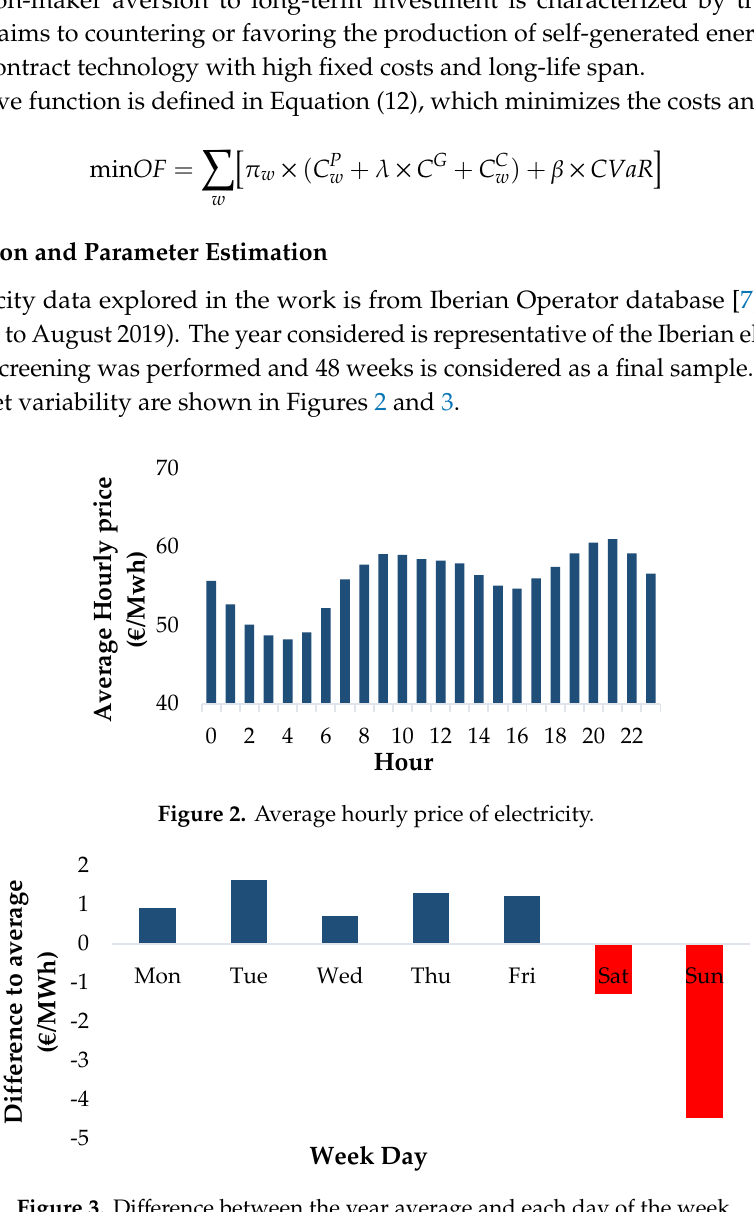
Table 1. Details of the weeks chosen to help in the scenario generation.